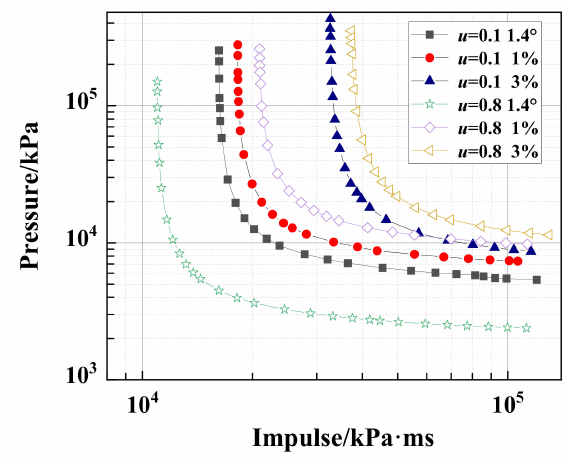
Figure 23. Analysis of P-I curves with two axial compression ratios, 0.1 and 0.8.